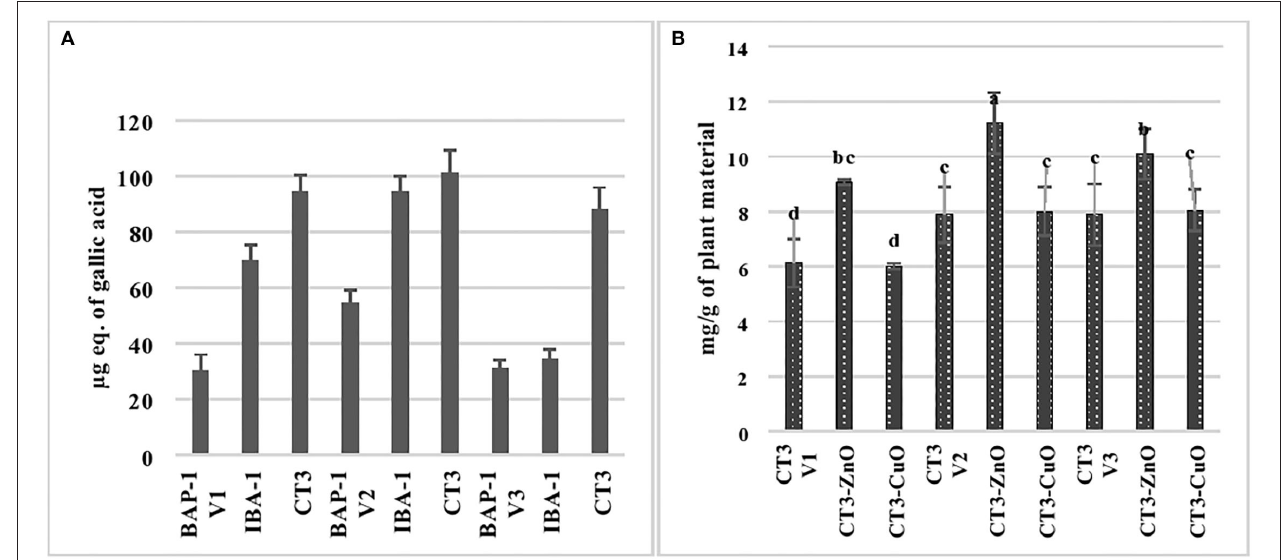
FIGURE 7 | Phenolic (A) and glycoside (B) analysis of copper oxide and zinc oxide nanoparticles elicited cultures of three varieties of mung